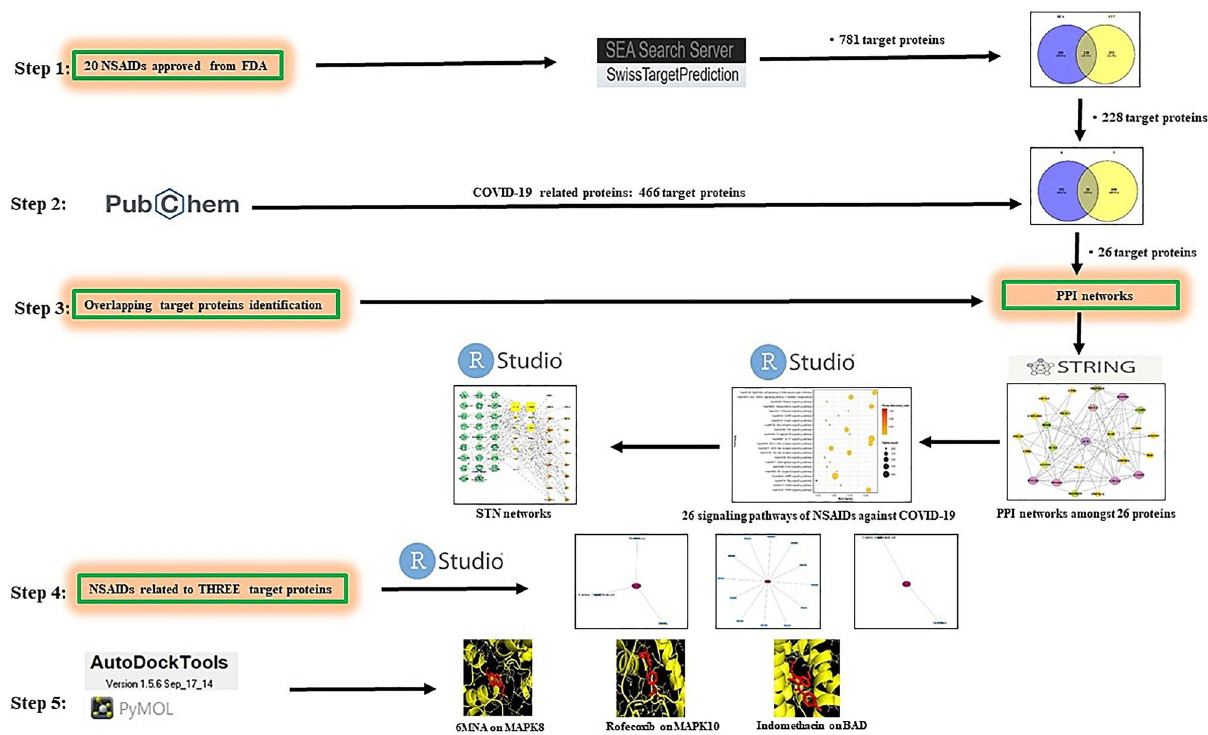
Figure 1. Workflow of network pharmacology analysis of NSAIDs against